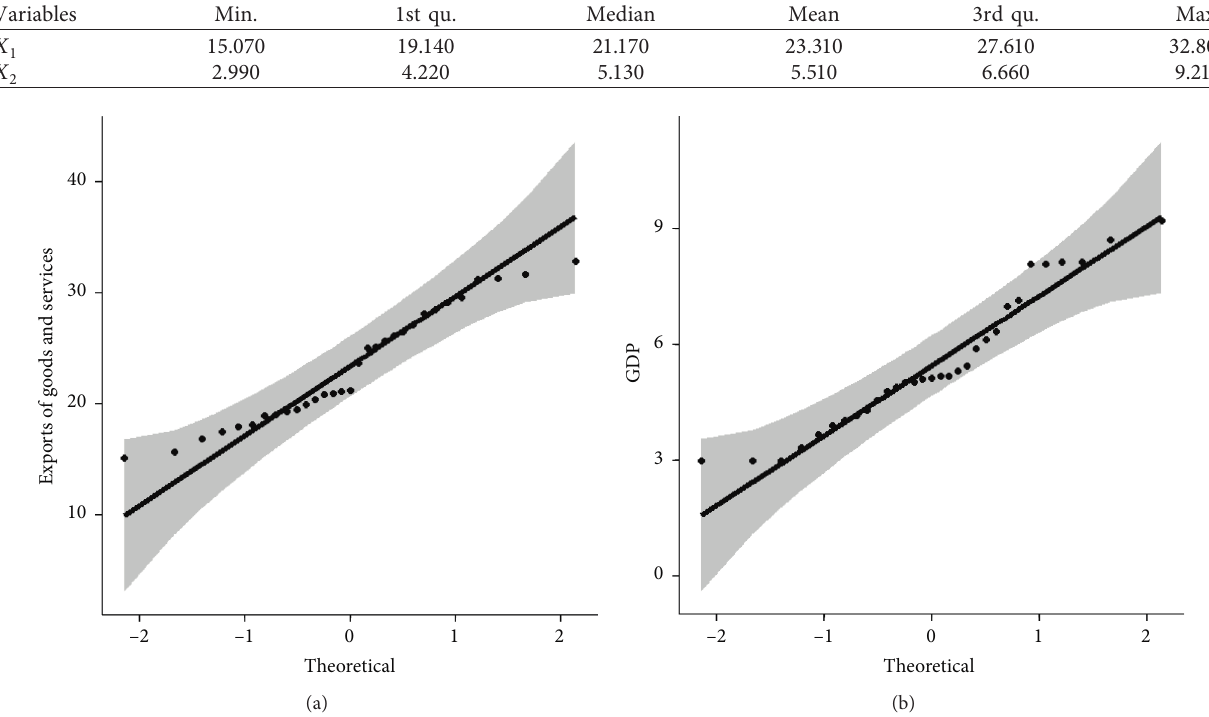
Figure 13: Graphical display of the QQ plot and SW test statistic